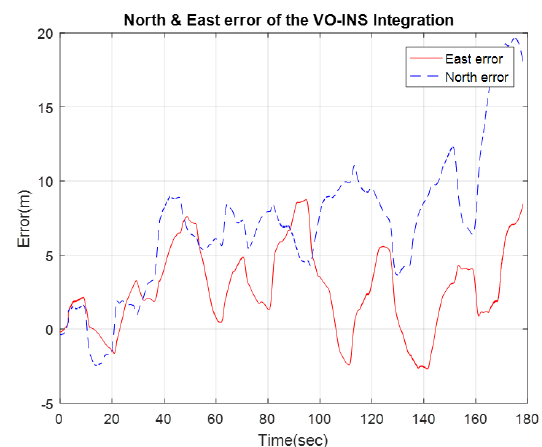
Figure 10. RMSE errors trend in North and East directions for the solution of the camera and INS integration